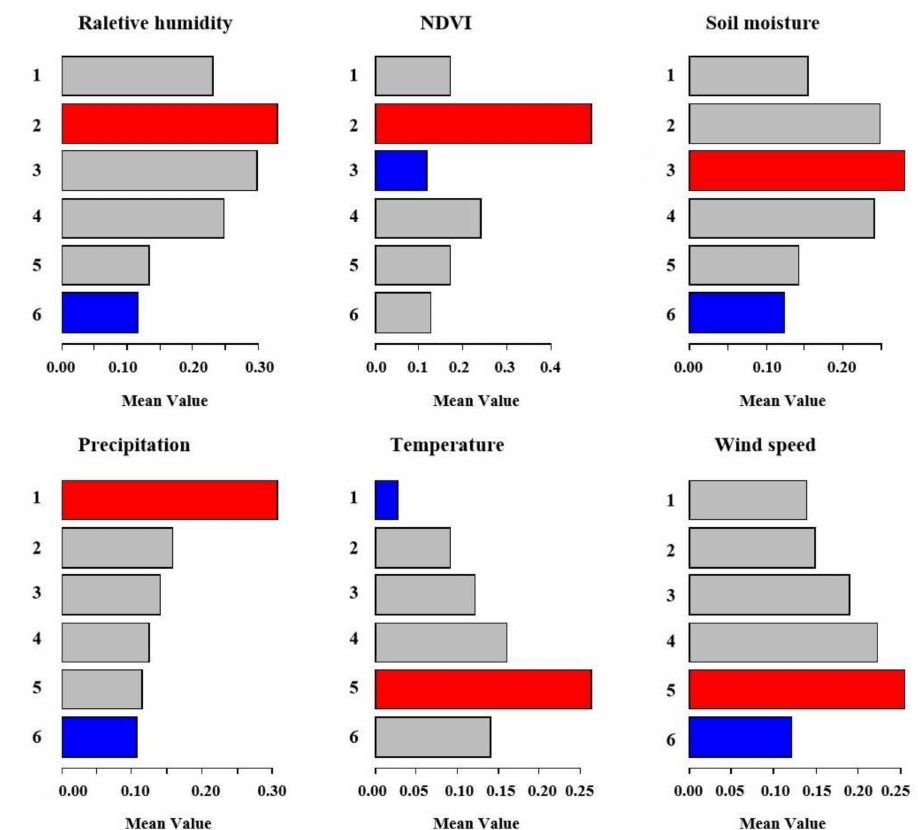
Figure 12. Risk detection results: the x -axis is the mean value of AOD under the influence of different factors; the y -axis shows the different ranges of factors, gradually increasing from 1 to 6. Red and blue colors indicate the highest and lowest AOD values in this range,